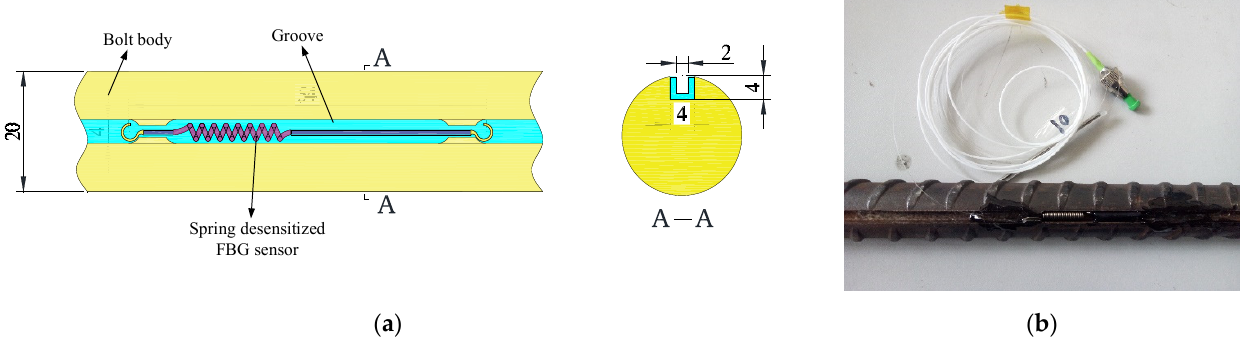
Figure 7. Schematic diagram and photo of the bolt structure where the sensor is located. ( a ) Schematic diagram; ( b ) photo.